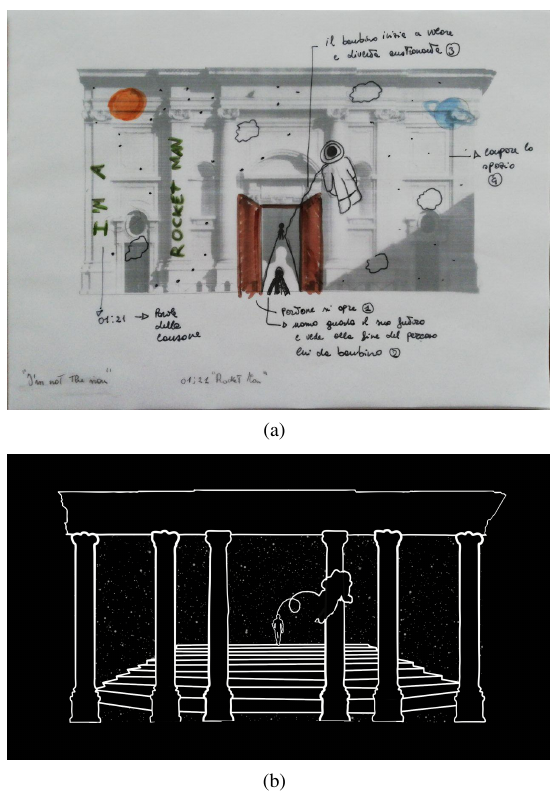
Figure 7. Two drawings belonging to To the moon: the by-hand drawing (up), the digital one that becomes a video frame (down).